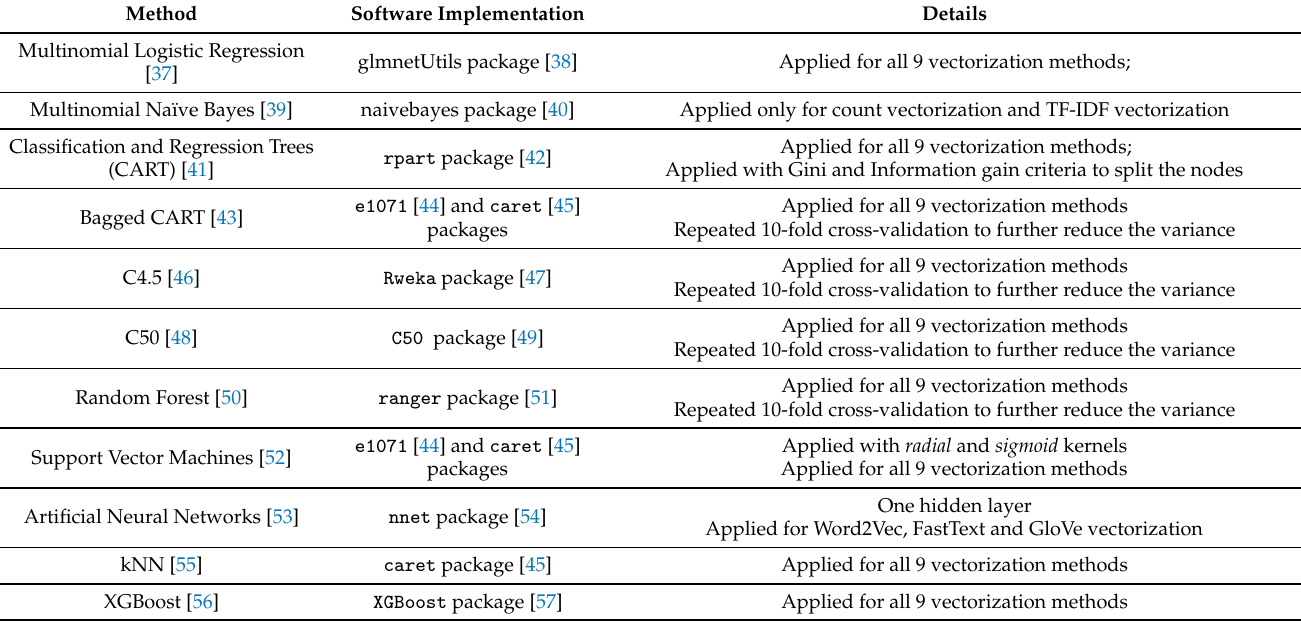
Table 5. Machine learning classification